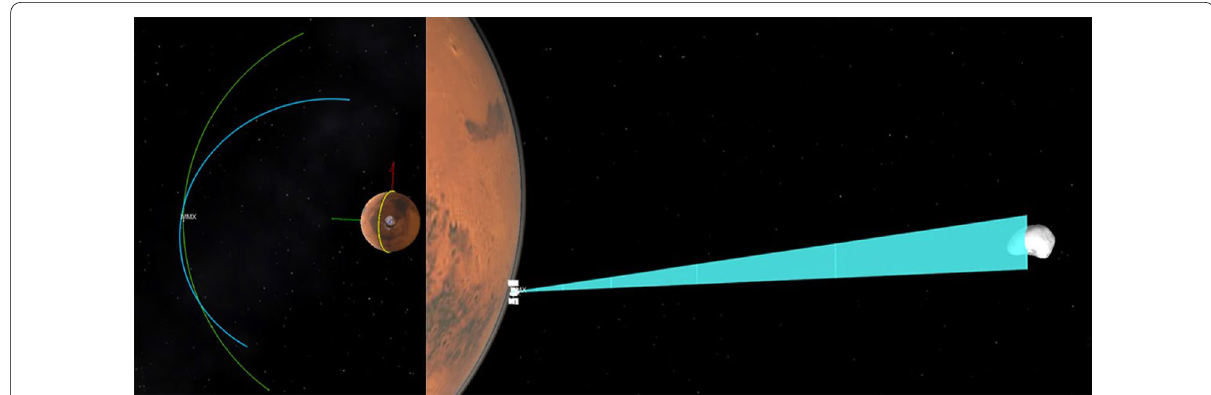
Fig. 22 Deimos observation by MIRS from an elliptical orbit. On the left, Deimos orbit in green and MMX orbit in blue. On the right, example of MIRS line of sight in blue pointing to Deimos at closest distance of 300 km (nadir resolution is 105